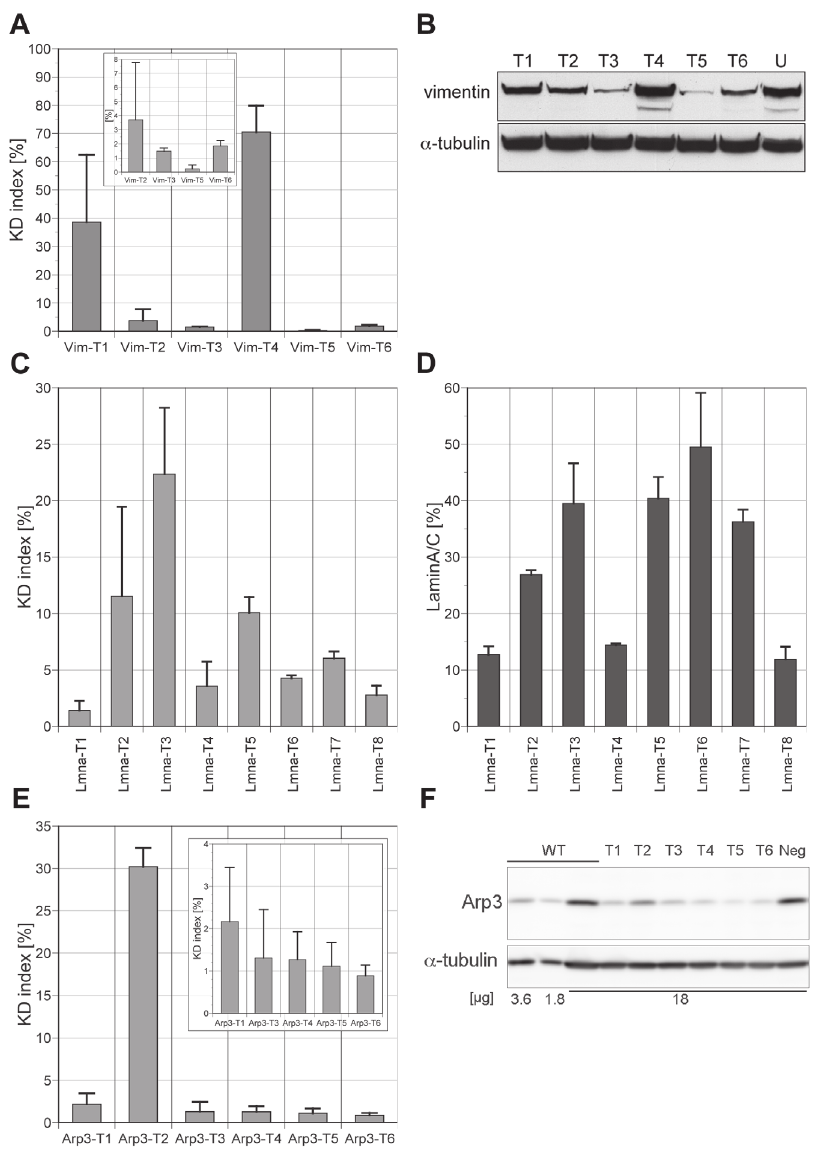
Figure 3. Validation of knockdown (KD) indexes in three test systems. The KD indexes were calculated from the medians of the R/G ratios. Bar graphs show the averages and standard deviations of the KD indexes in two or three experiments for each test system. ( A , B ) vimentin; ( C , D ) lamin; ( E , F ), Arp3. ( A ) KD indexes for Vim-T1 to -T6. The KD indexes of Vim-T2, -T3, -T5 and -T6 are also shown in the inset on an expanded scale. ( B ) Western blotting of HeLa cells for vimentin. HeLa cells were electroporated with each of the pSHIN-G-Vim constructs. In each lane, 30 µg of the protein sample was loaded. After detection with anti-vimentin antibody, the same membrane was analyzed by anti- α -tubulin antibody (loading control). ( C ) KD indexes for Lmna-T1 to -T8. ( D ) Quantification of expression level of laminA/C. The laminA/C expression levels of transfectants as assayed by immunofluorescence were normalized to the averages of untransfected cells. In each experiment, the median of the laminA/C of 50–225 transfected cells was calculated. The averages and standard deviation of two experiments are shown. ( E ) KD indexes for Arp3-T1 to -T6. The graph in the inset uses an expanded scale for the y-axis. ( F ) Western blotting of B16S cells for Arp3. B16S cells were transfected with one of pSHIN-puro-Arp3 constructs, and selected in the presence of puromycin for 2 days. For transfected and puromycin-selected cells (Arp3-T1 to -T6, and neg), 18 µg of the protein sample was loaded per lane. For untransfected cells (WT), a dilution series of the protein sample was loaded. The same membrane was analyzed by anti-Arp3 and anti- α -tubulin antibodies (loading